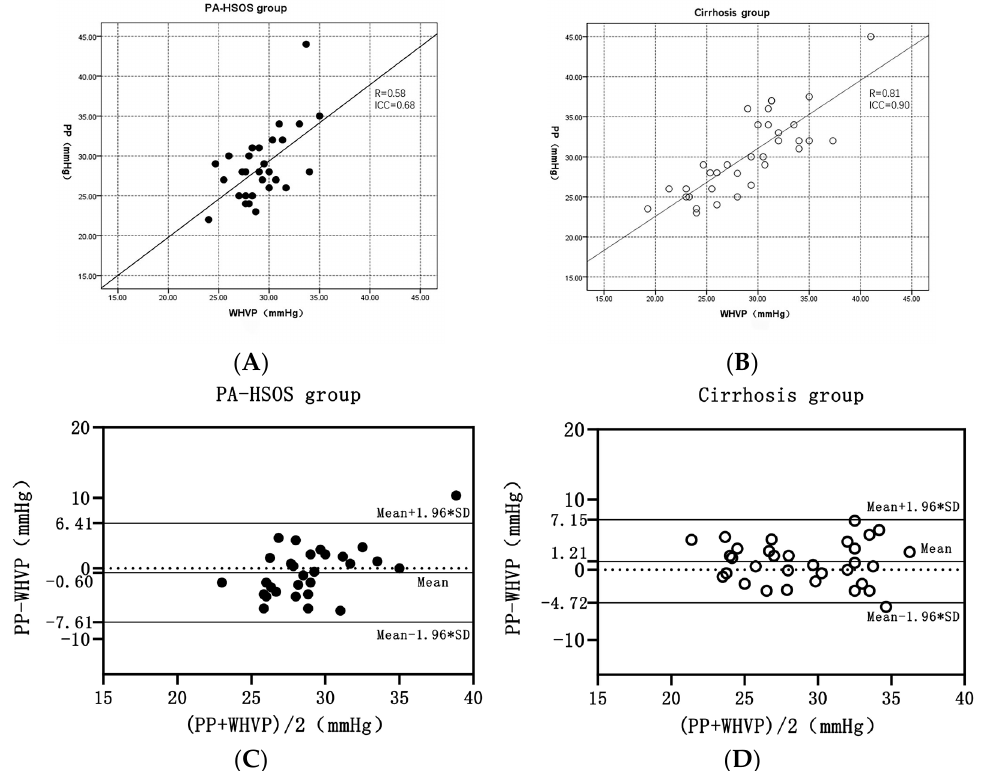
Figure 1. Correlation between WHVP and PP according to a scatter plot and the Altman and Bland plot. ( A ). In the patients with PA-HSOS ( n = 30), the strength of the linear correlation between WHVP and PP was moderate (R: 0.58; ICC: 0.68). ( B ). In the patients with cirrhosis ( n = 34), the strength of the linear correlation between WHVP and PP was excellent (R: 0.81; ICC: 0.90). ( C ). In the PA-HSOS group ( n = 30), one point was not within 95% of the mean difference between WHVP and PP, which ranged from −7 .61 to 6.41 mmHg. ( D ). In the cirrhosis group ( n = 34), two points were not within 95% of the mean difference between WHVP and PP, which ranged from −4 .72 to 7.15 mmHg. Table 3. Performance of WHVP in evaluating PP.